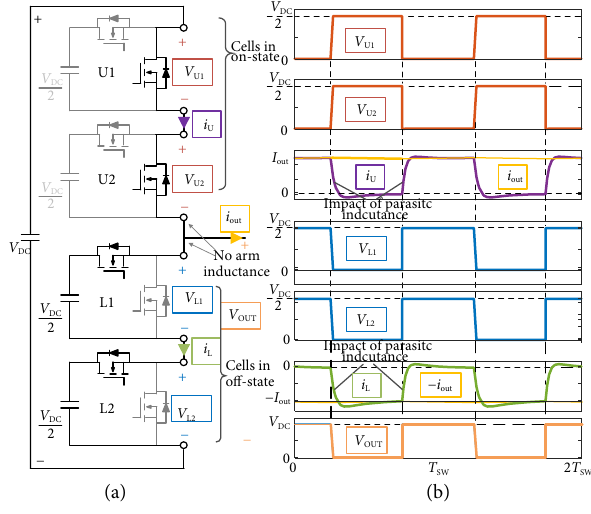
Fig. 12 (a) Two-cell-per-arm ICBT configuration. (b) Representative wave- forms.